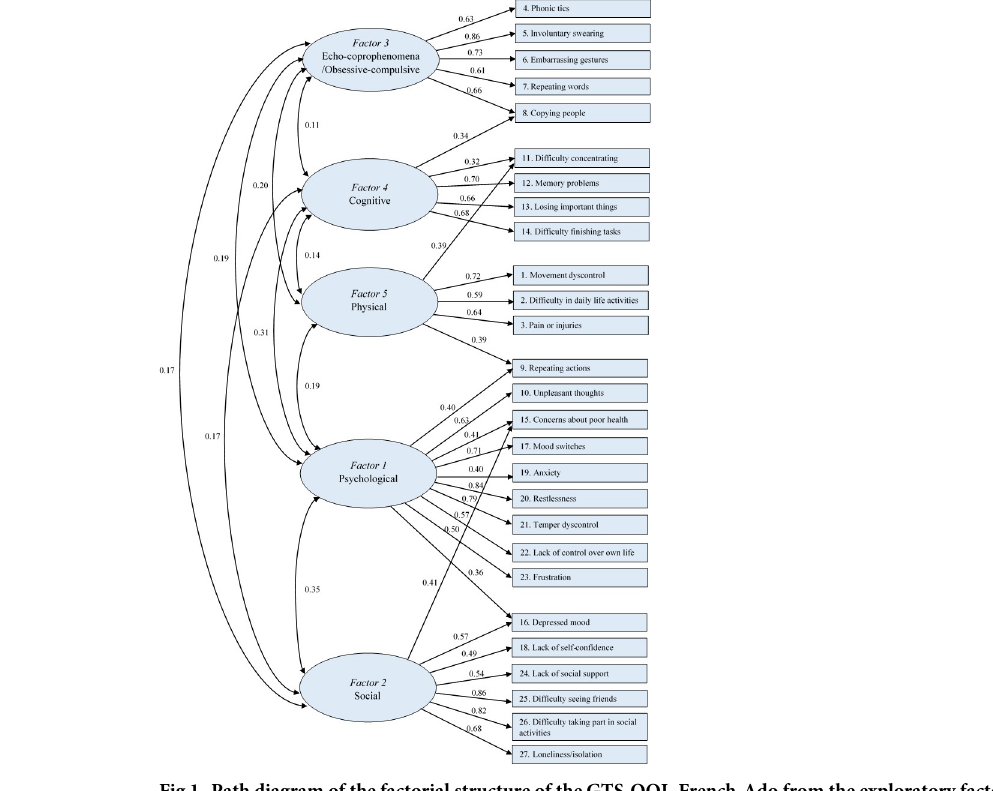
Fig 1. Path diagram of the factorial structure of the GTS-QOL-French-Ado from the exploratory factor analysis. Factor latent variables are represented by ellipses. Measured variables (items of the GTS-QOL-French-Ado) are represented by rectangles. The curved double-headed links represent the correlations among factors. The directed links from factors to items represent the factor loadings estimates. The path diagram displays only the links that have loadings equal or greater than 0.32.